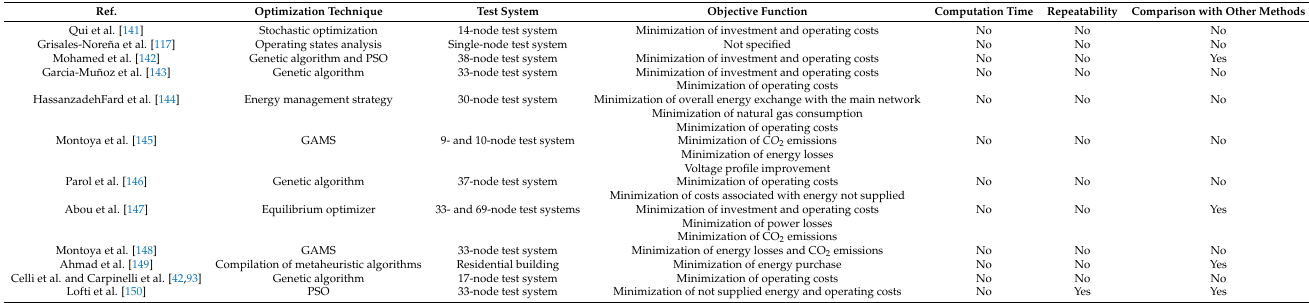
Table 3. Methodologies for the optimal sizing and location of DGs and